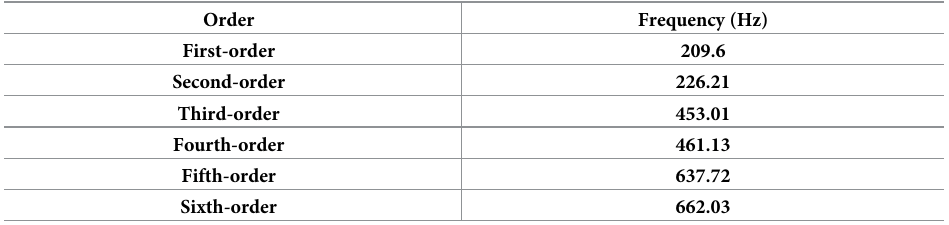
Table 2. Natural frequency of each